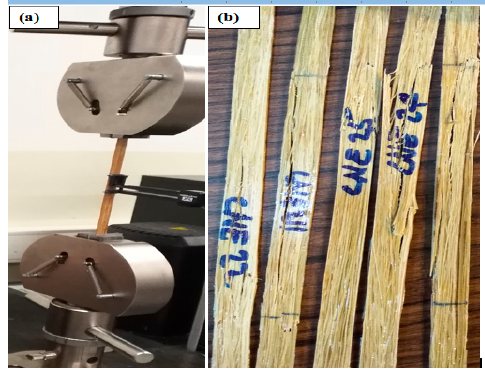
Figure 4. ( a ) Set-up of the tensile test machine; ( b ) mode of failure.